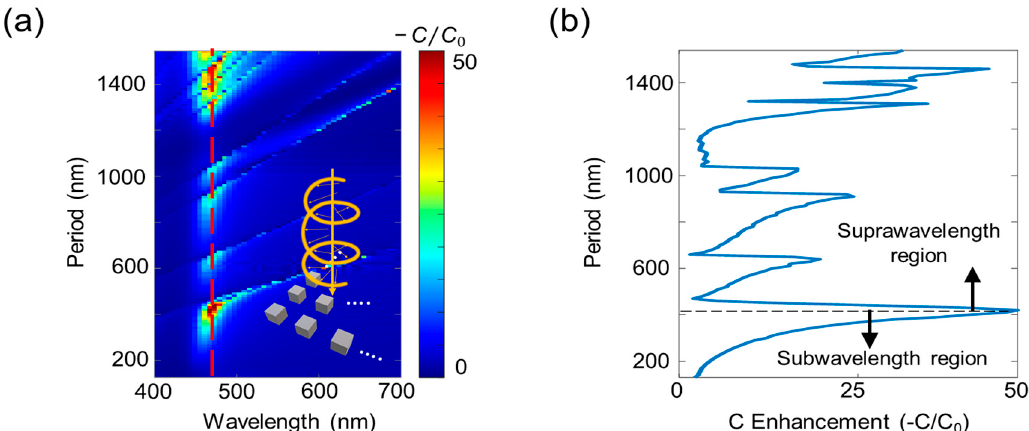
Figure 6. The optical C enhancement in the periodic structure. ( a ) A two-dimensional map of the optical C enhancement of a Si nanoblock array for the periods of the nanostructure. ( b ) The C enhancement with respect to the periods. The resonance wavelength of 475 nm indicated as the red dotted line in ( a ).